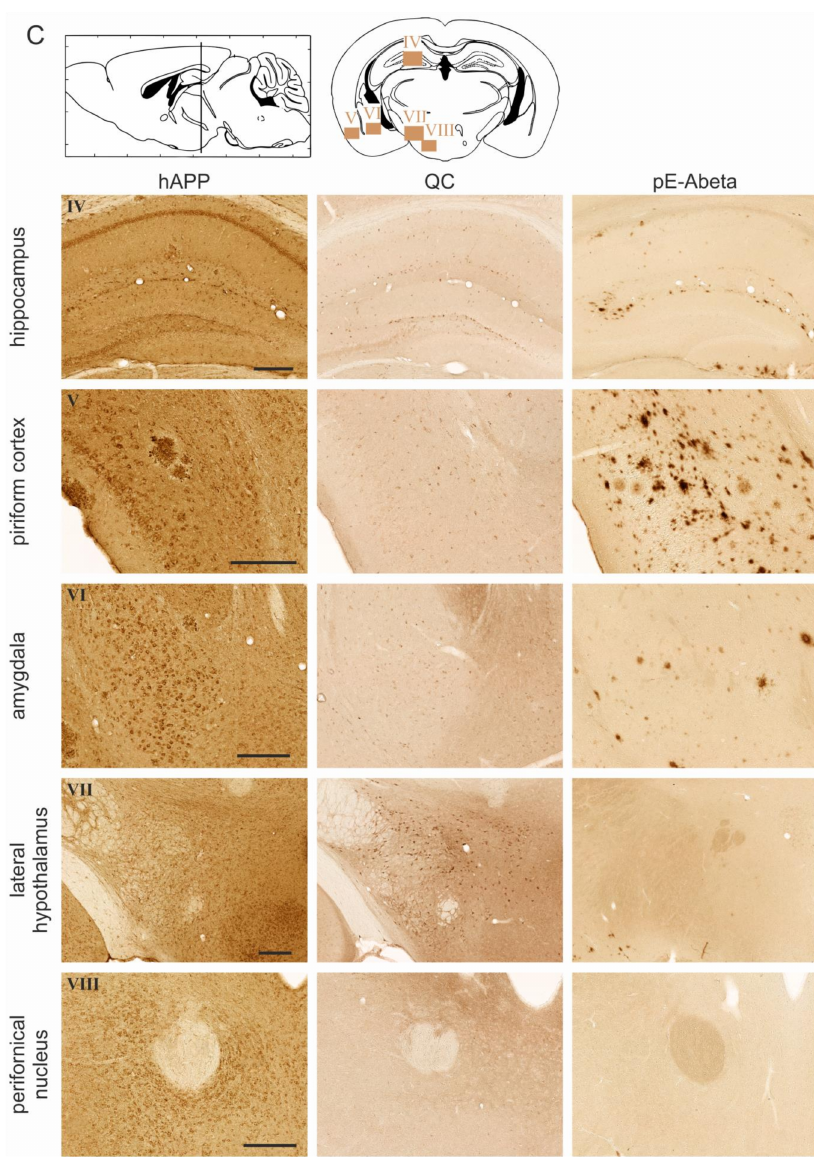
Figure 3. Immunohistochemical labelings for hAPP, QC, and pE-Abeta in Tg2576 mouse brain. The presence of hAPP, endogenous QC, and pE-Abeta was analyzed at four coronal brain cutting levels as indicated in the schematic sagittal brain sections. In the schematic coronal brain sections, the areas of interest are marked with light brown squares and Roman numerals (I to VIII) to allow identification of the immunohistochemical images. Mice at the age of 18 months were used to monitor hAPP transgene expression and pE-Abeta pathology. The expression of endogenous QC was analyzed in three-month-old mice. In the anterodorsal thalamic nucleus, ( A ) hAPP is expressed, while QC and pE-Abeta were not detected, consistent with QC being a prerequisite for pE-Abeta formation. In the Edinger-Westphal nucleus and locus coeruleus ( B ), both hAPP and QC are highly abundant; however, pE-Abeta pathology is absent. In other brain regions with substantial hAPP and QC expression (hippocampus, piriform cortex, and amygdala), pE-Abeta deposits were present. In contrast, in brain regions with high hAPP and low QC expression (perifornical nucleus) or with low hAPP and high QC expression (lateral hypothalamus), no pE-Abeta pathology was detected ( C ). Scale bars in ( A – C ) represent 200 µ